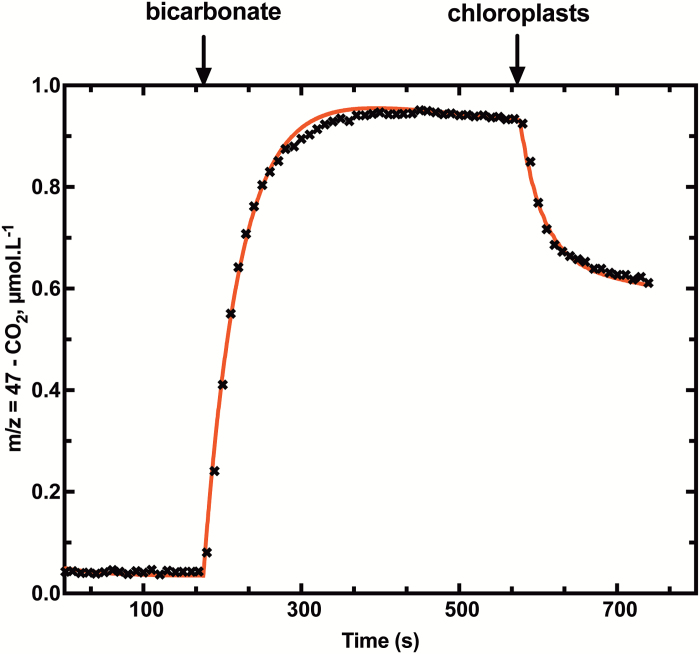
Time course (black crosses) of 13C18O16O (m/z=47) and curve fitting (red line) using COPASI software as described in the Materials and methods. Low 18O-enriched Ci (2.5 mM) was injected at t=170 s, and chloroplasts at t=577 s after chemical equilibrium had been reached.